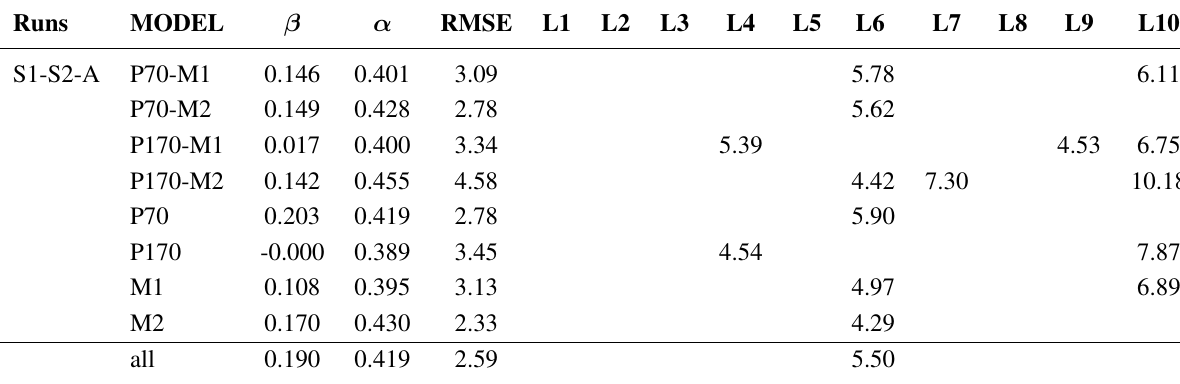
Table 5. α and β parameters for the LIE models obtained from simulation sets S1 and S2, by averaging results for pairs of S1 and S2 simulations. For each LIE model, root-mean-square errors (RMSEs, in kJ mol − 1 ) between calculated ( ∆ G ) and experimental binding free calc energies ( ∆ G ) are shown as well, together with errors (in kJ mol − 1 ) in the prediction exp for the compounds (outliers) for which ∆ G deviates by more than 1 kcal mol − 1 calc (4.184 kJ mol − 1 ) from ∆ G exp